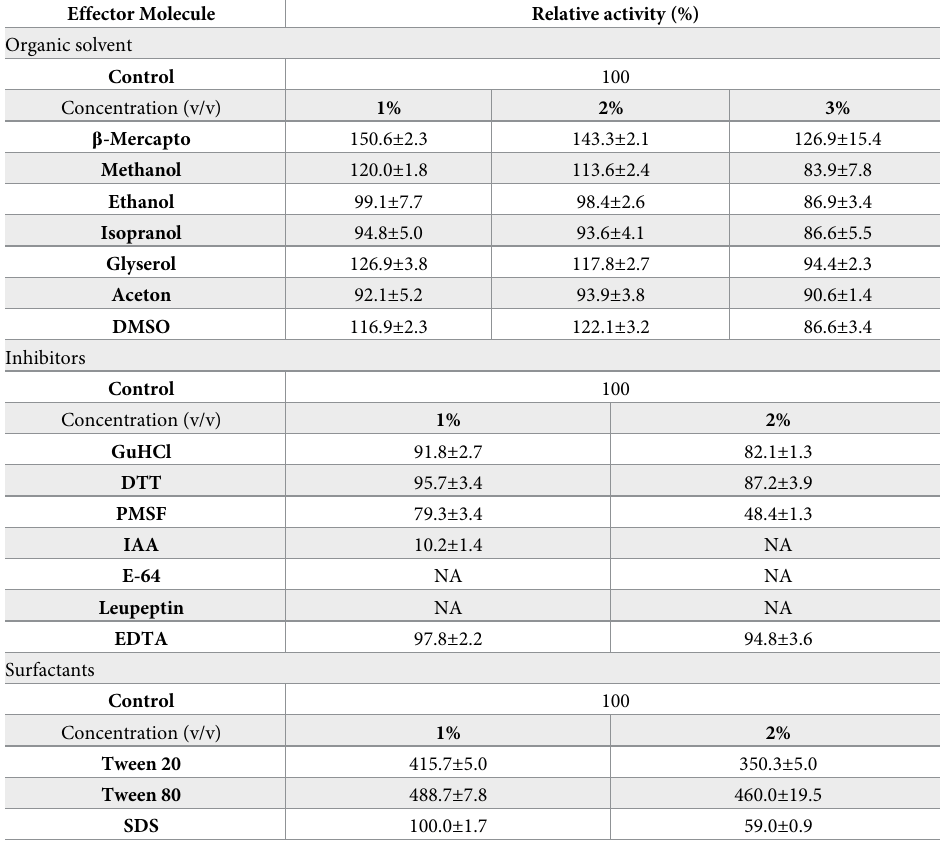
Table 4. Effects of various organic solvents, inhibitors, and surfactants on protease 1147 activity. Each value rep- resents the mean of three independent replicates with a standard deviation. Effector Molecule Relative activity